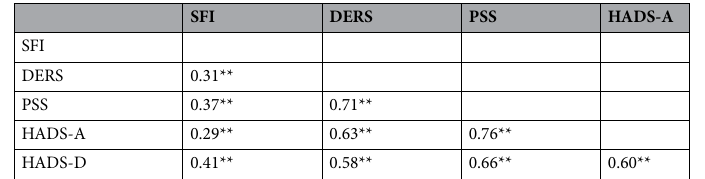
Table 2. Pearson correlations between key variables. SFI Social Frailty Index, DERS Difficulties in Emotion Regulation Scale, PSS Perceived Stress Scale, HADS-A/D Hospital Anxiety and Depression Scale-Anxiety/ Depression subscale. ** indicates p < .01.